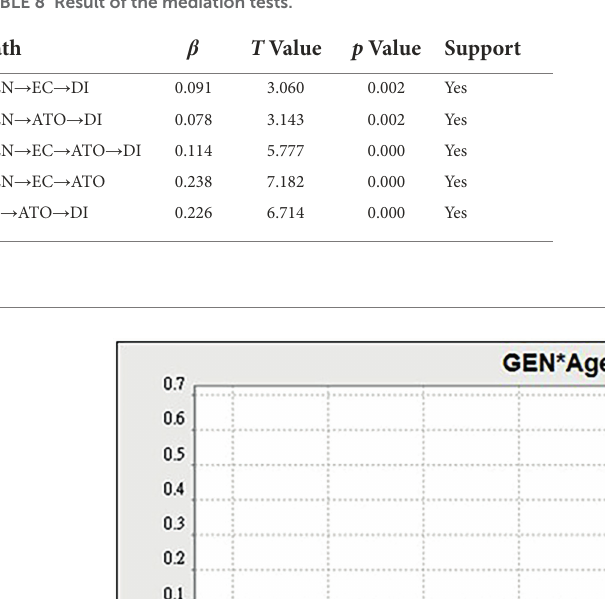
TABLE 8 Result of the mediation tests.